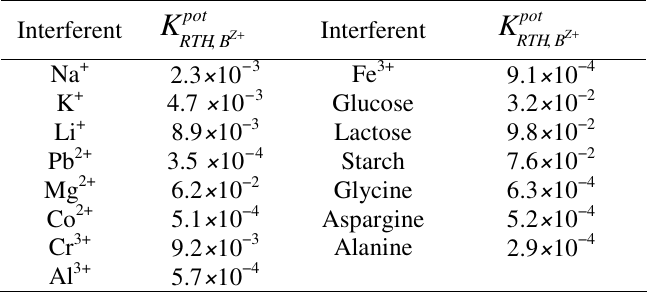
Table 4 . Selectivity coefficients of the RTH-selective electrode calculated by the